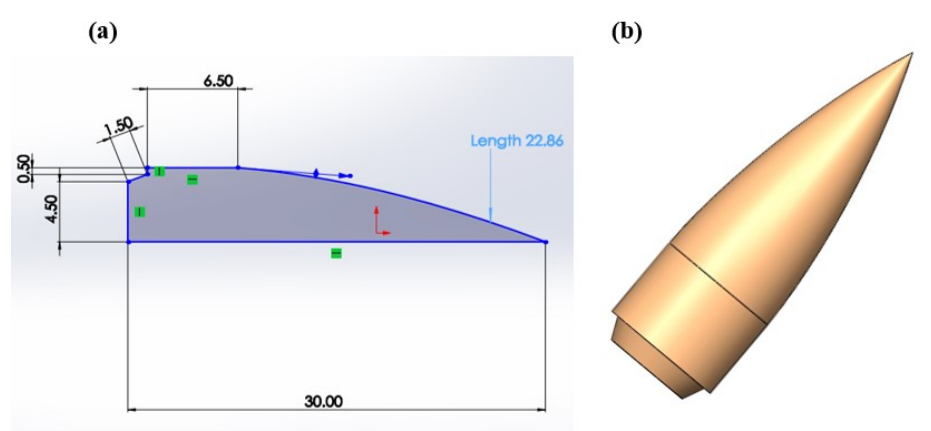
Figure 2. Dimensions ( a ) and geometry ( b ) of the bullet head in design II. Table 2. Conditions of bullet head in design II.